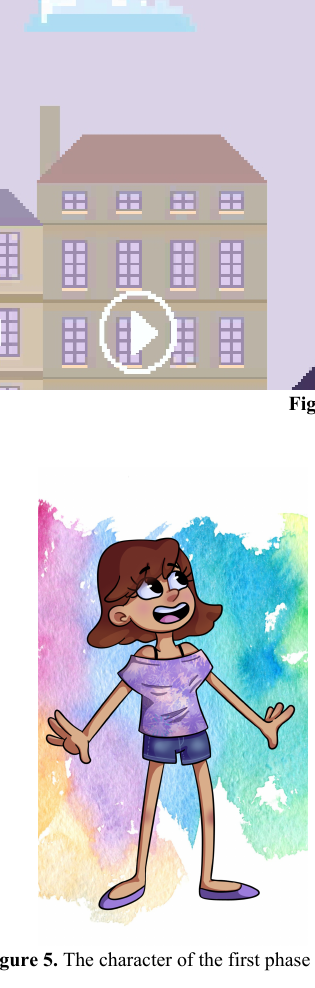
Figure 5. The character of the first phase -